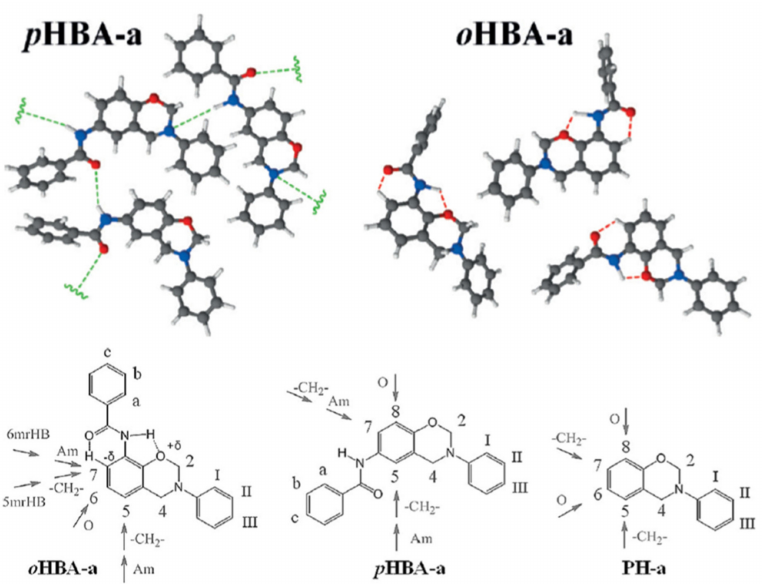
Figure 72. Proposed hydrogen-bonding interactions in oHBA-a and pHBA-a. Above is shown the intermolecular hydrogen bonding in both o HBA-a and p HBA-a, intramolecular in o HBA-a, and the influence of the amide substituent at the ortho and para positions in the benzoxazine nuclei. The arrows show the “activating action” produced by the different substituents and their effects, with Am referring to the amide group, >CH 2 to the methylene group at the 4-position, O to the oxygen atom in the oxazine ring and 5mrHB and 6mrHB to the five- and six-membered-ring hydrogen-bonding systems, respectively [415]. Copyright 2016 and 2012, respectively. Reproduced with permission from John Wiley & Sons,